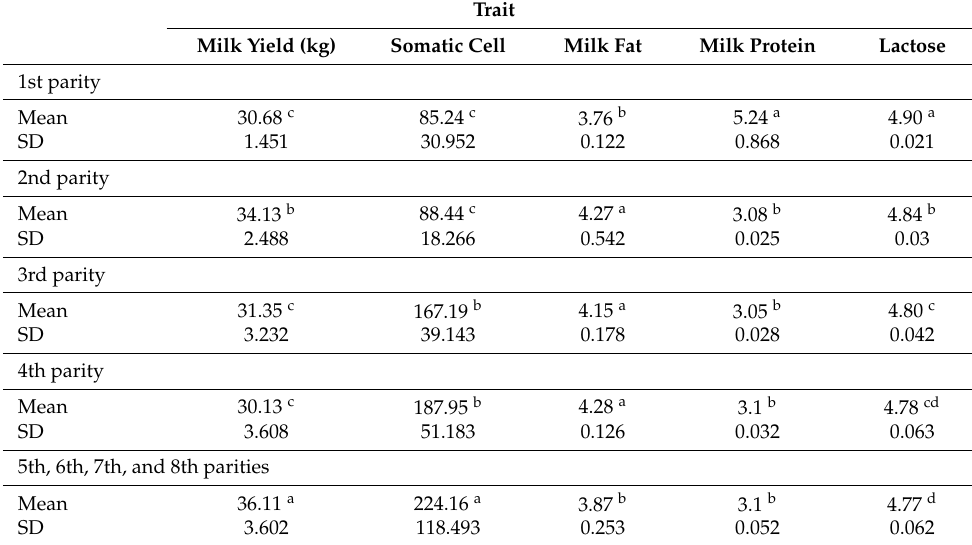
Table 4. Mean and standard deviations (SDs) of considered traits for milking in the groups designated by parity number in the South Korean